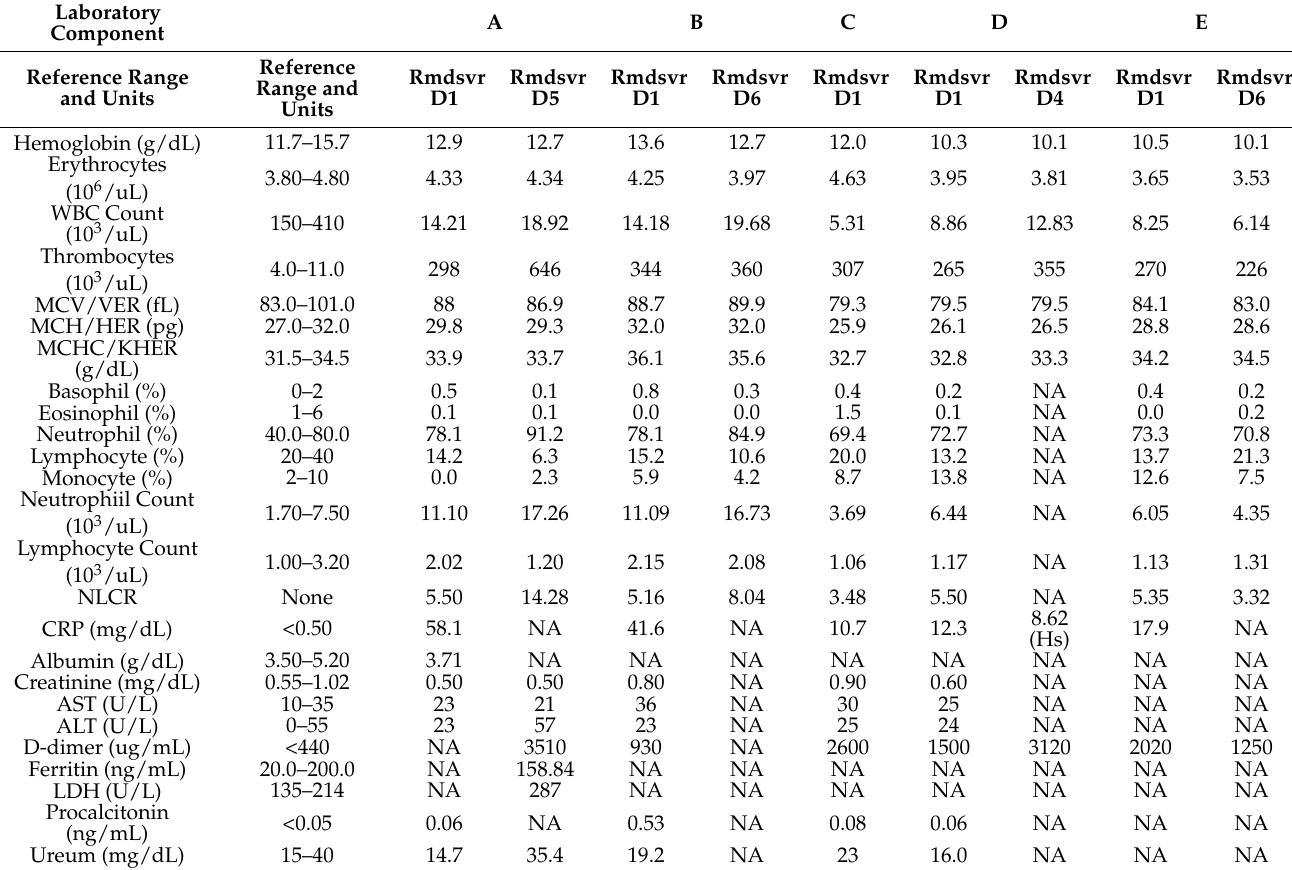
Table 1. Laboratory findings in pregnant women treated with Remdesivir